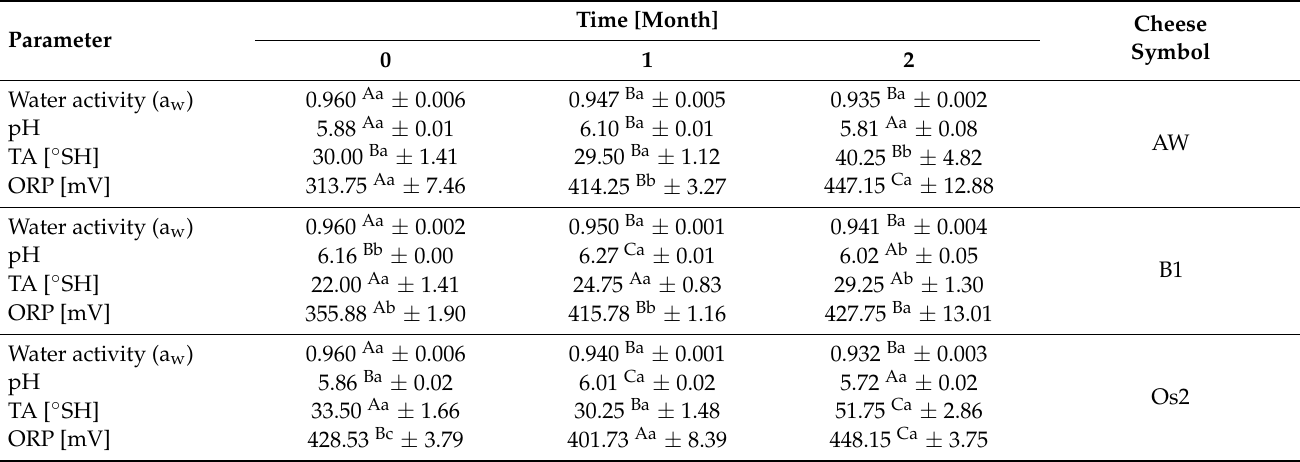
Table 4. Mean values of water activity, pH value, oxidation-reduction potential and total acidity of acid-rennet goat’s cheeses after production and after 1 and 2 months of